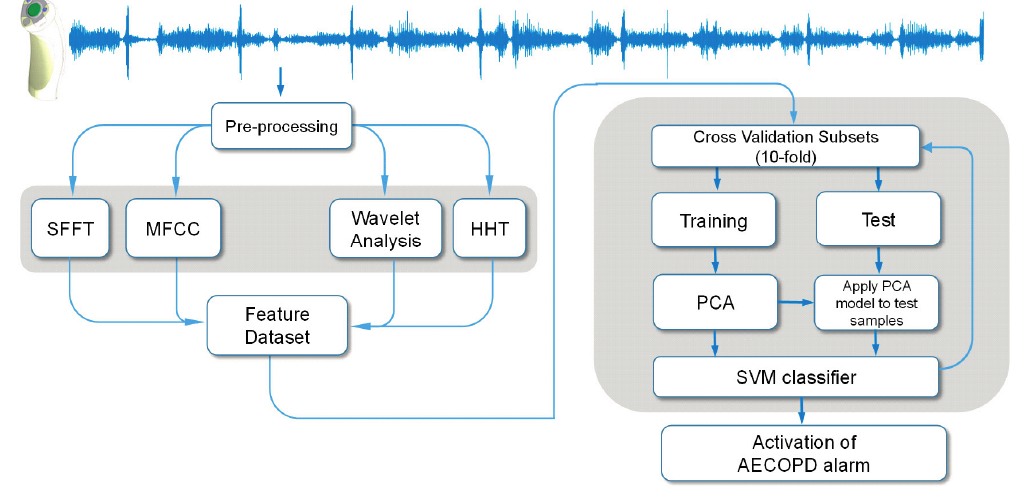
Figure 4. Flow diagram depicting the computational approach to the early detection of acute exacerbation of